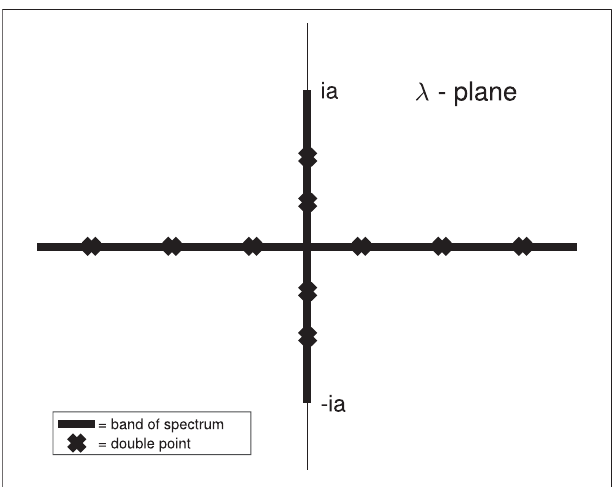
FIGURE 1 | The Floquet spectrum of the Stokes wave with P aL / π (cid:18) (cid:1)